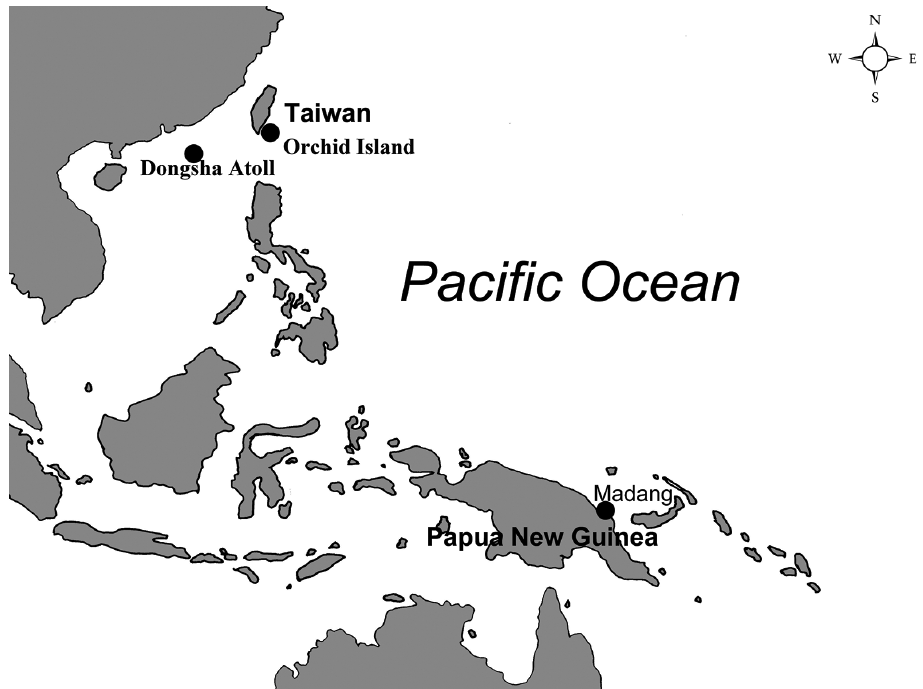
Figure 1. Collection sites of the Galkinius maculosus sp. n. in the Pacific